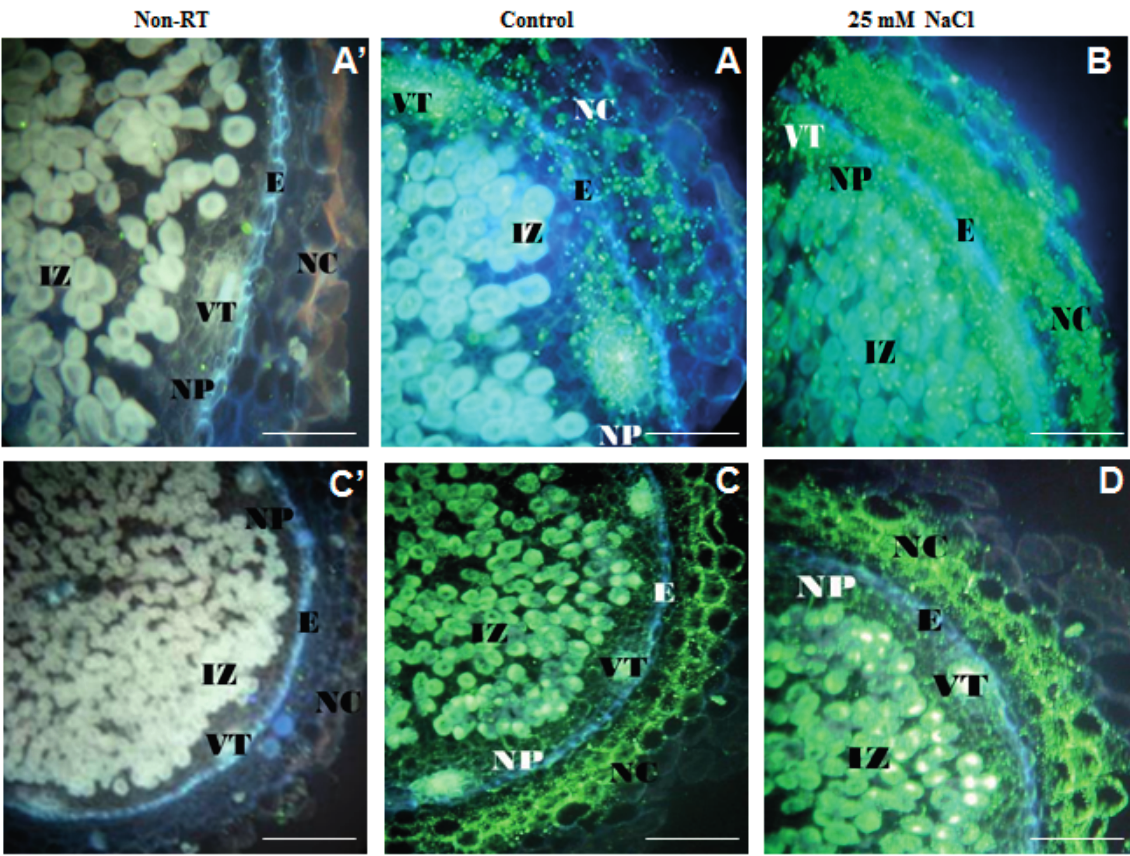
Figure 2. In situ RT-PCR localization of ascorbate peroxidase (APX2, ( A , B ), 200 μ m) and Protein Phosphatase 2C (PP2C, ( C , D ), 500 μ m) transcripts in cross sections of C. arietinum nodules under salinity constraint. Negative controls without reverse transcription (non-RT) are shown in ( A’ ) (200 μ m) for APX2 and ( C’ ) (500 μ m) for PP2C. Abbreviations: IZ (infected zone), NP (Nodule parenchyma), E (nodule endodermis) and NC (nodule cortex), VT (vascular trace). Images ( A , B ) used from Molina et al. [212] under the terms of the Creative Commons Attribution License (http://creativecommons.org/licenses/by/2.0). Images ( A’ , C’ , C , D ) are provided by Zaman-Allah